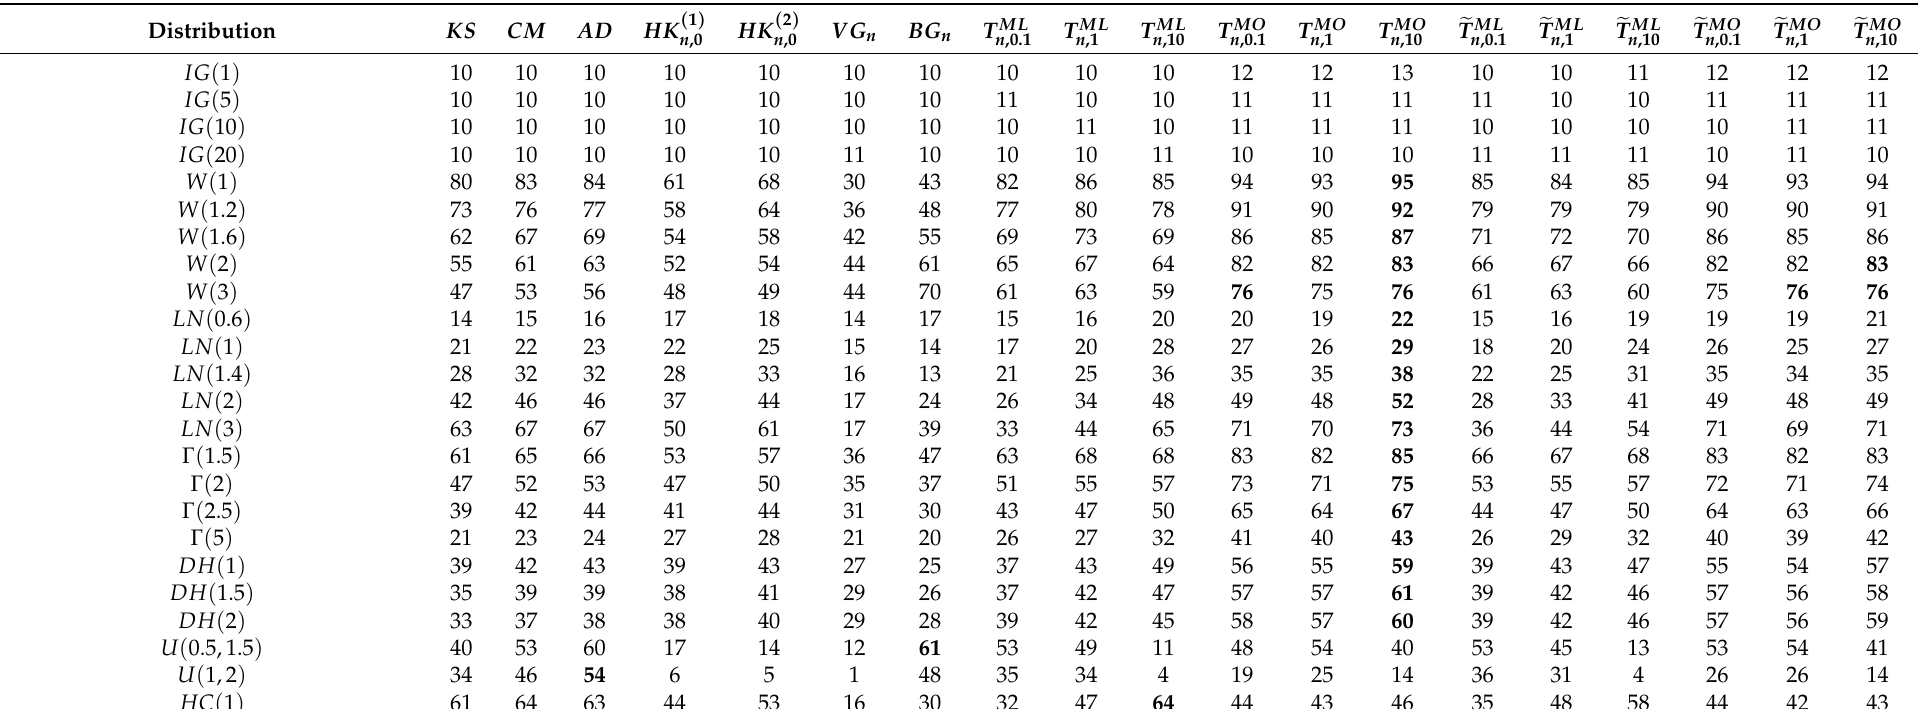
Table 2. Approximated powers for sample size n =